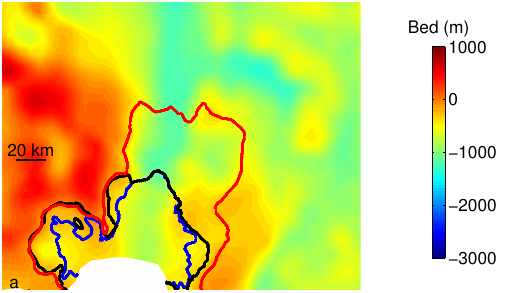
Figure 10. Grounding line position at the beginning of the experi- ments (blue line), and at the end of the melting experiments in the case of β = 1 (black line) and for a basal melting rate parameter- ization based on the ice shelf base elevation similar to Favier et al. (2014) (red line), overlain on the bedrock